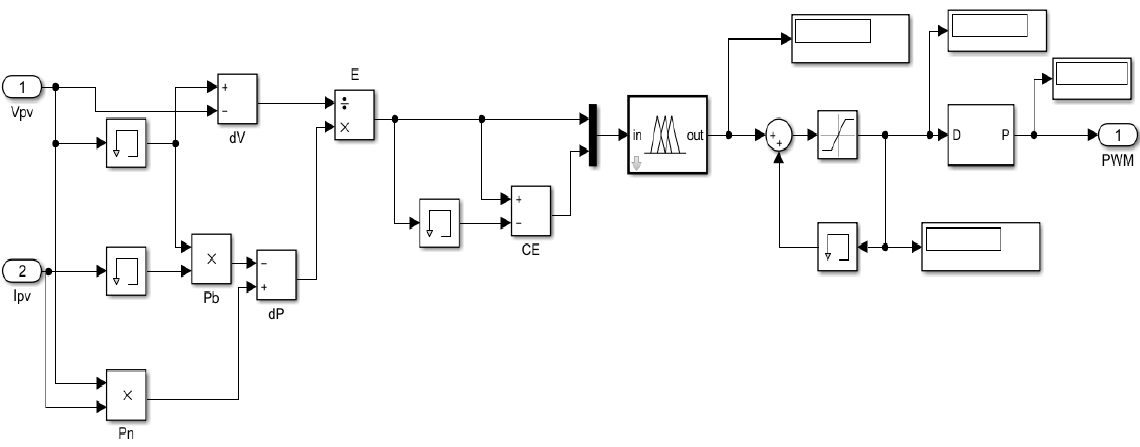
Figure 8. Simulink model of FLC. Table 2. Rules of the FLC.